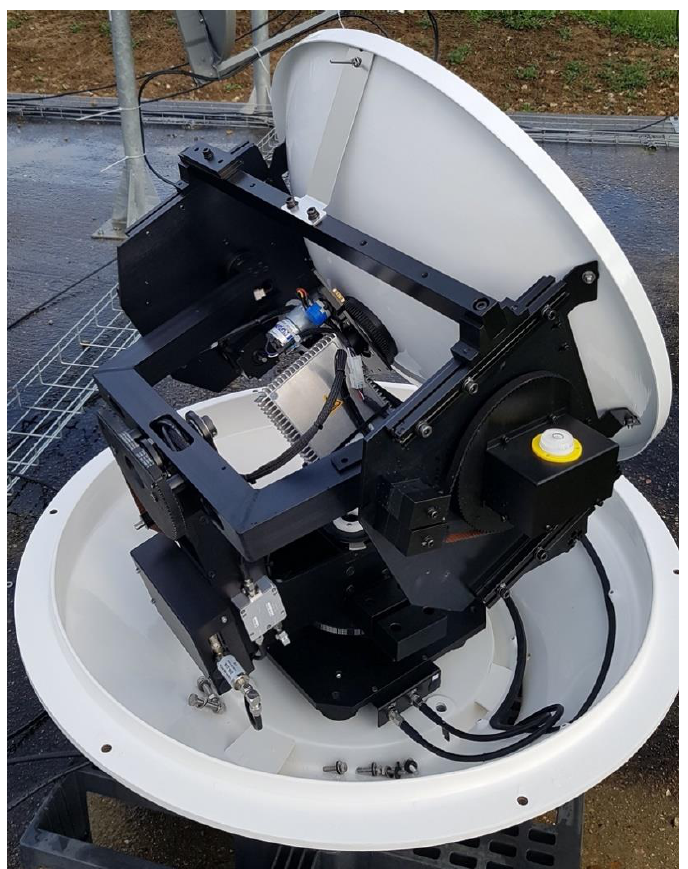
Figure 8. Egatel terminal mounted in a KNS maritime antenna.